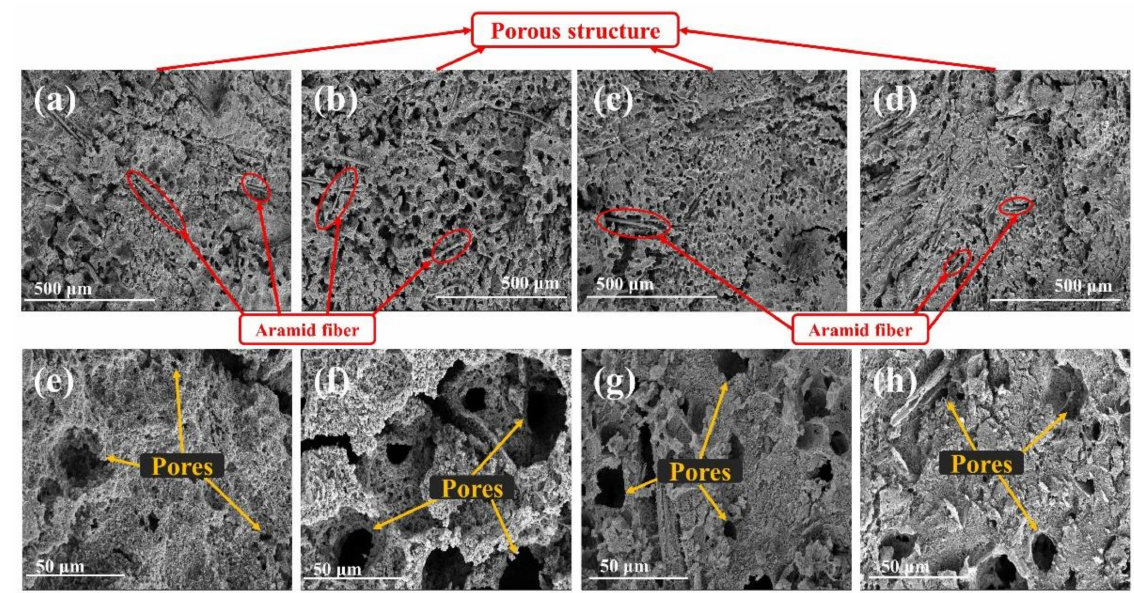
Figure 3. Effects of MWCNTs content on the char layer surface of EPDM-based insulators with silica: S-C-0 (400 × ( a ), 3000 × ( e )), S-C-0.3 (400 × ( b ), 3000 × ( f )), S-C-3 (400 × ( c ), 3000 × ( g )), S-C-6 (400 × ( d ), 3000 × ( h